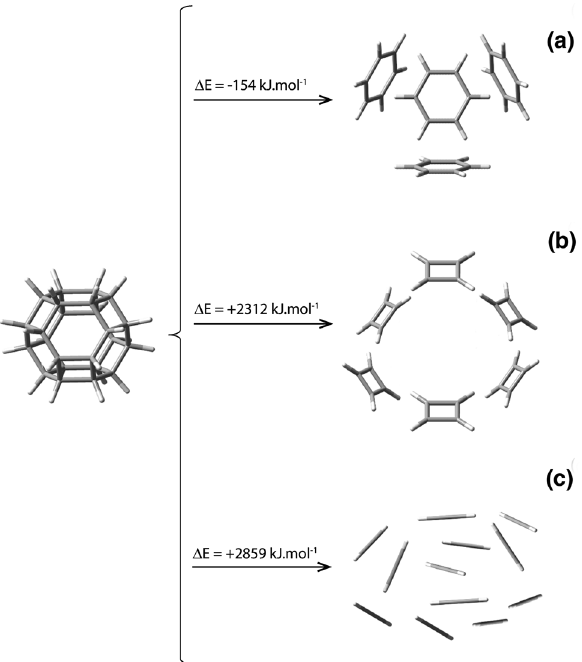
Figure 8. Pictorial representation of the dissociation reaction of nugget 24a into ( a ) four benzene molecules, C 24 H 24 → 4C 6 H 6 , ( b ) six cyclobutadiene compounds C 24 H 24 → 6C 4 H 4 , and ( c ) twelve ethyne molecules C 24 H 24 → 12C 2 H 2 . The values of ΔE shown are from ωB97XD/6-31G* calculations and are given in kJ mol −1 units because they refer to chemical reactions involving one mole of reactant